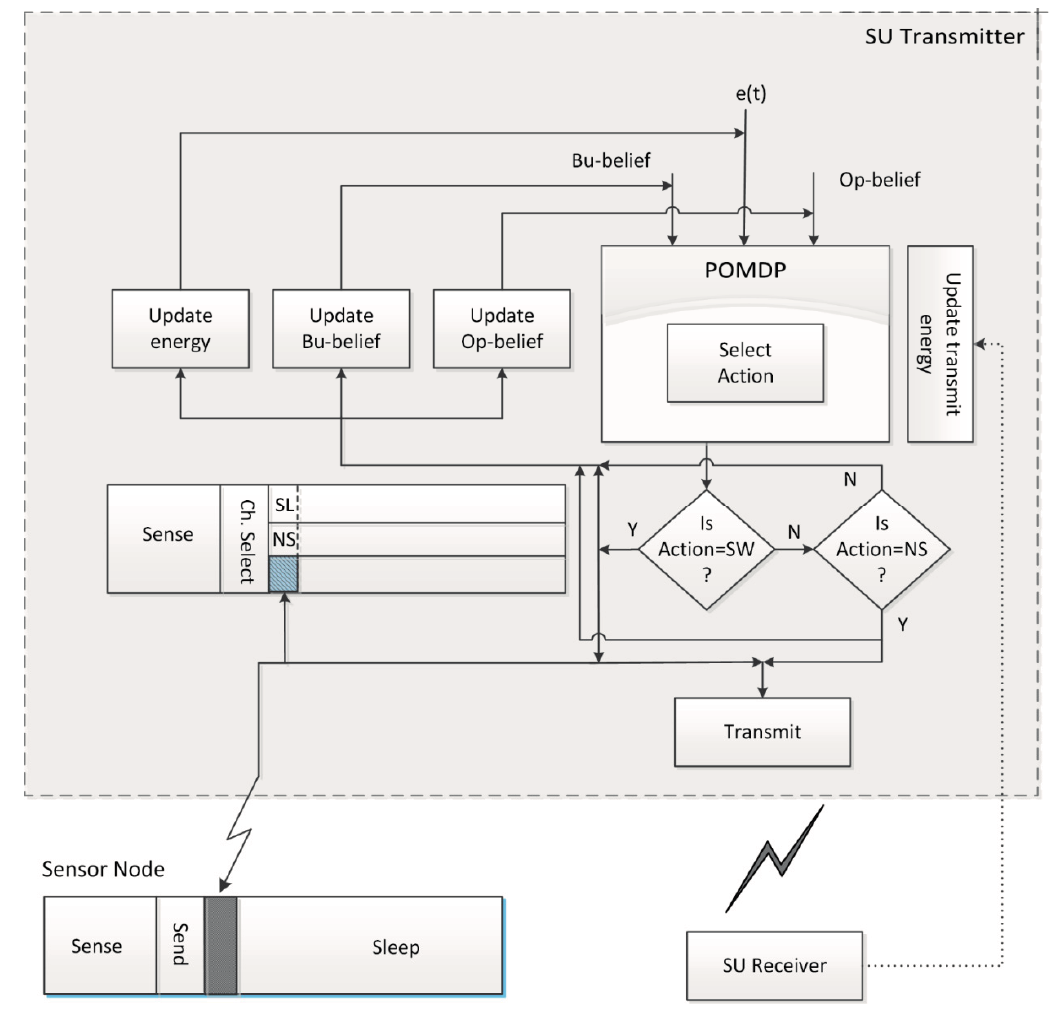
Figure 4. Flowchart of the proposed